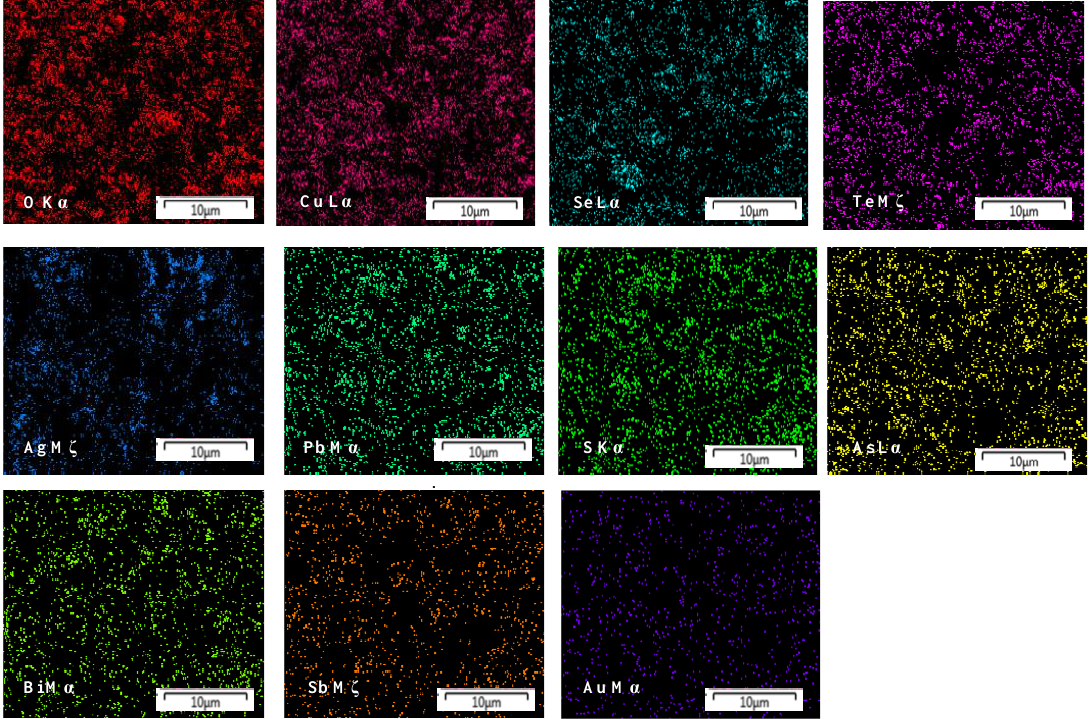
Figure 1. X-ray diffraction pattern of the copper anode slime.